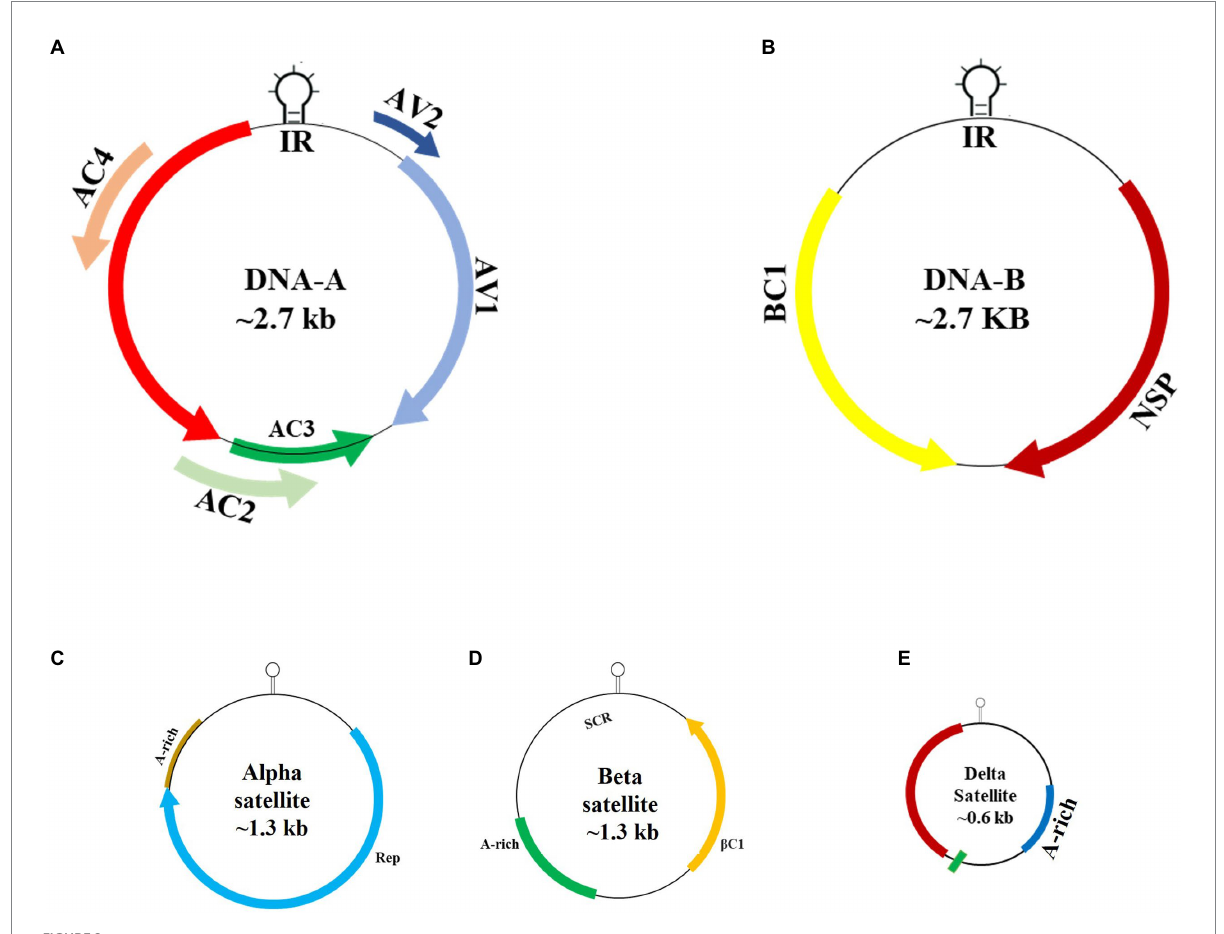
FIGURE 2 Begomovirus genome: (A) DNA-A segment of begomovirus. (B) DNA-B segment found in bipartite begomovirus along with DNA-A. (C) Alphasatellite, (D) betasatellite and (E) deltasatellite associated with monopartite